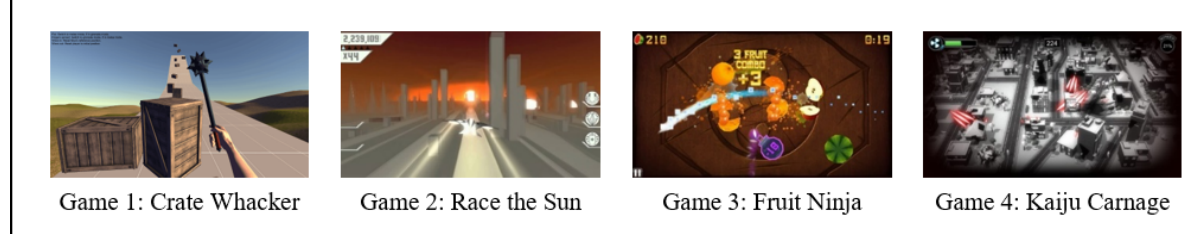
Figure 1. Selected open-source games.